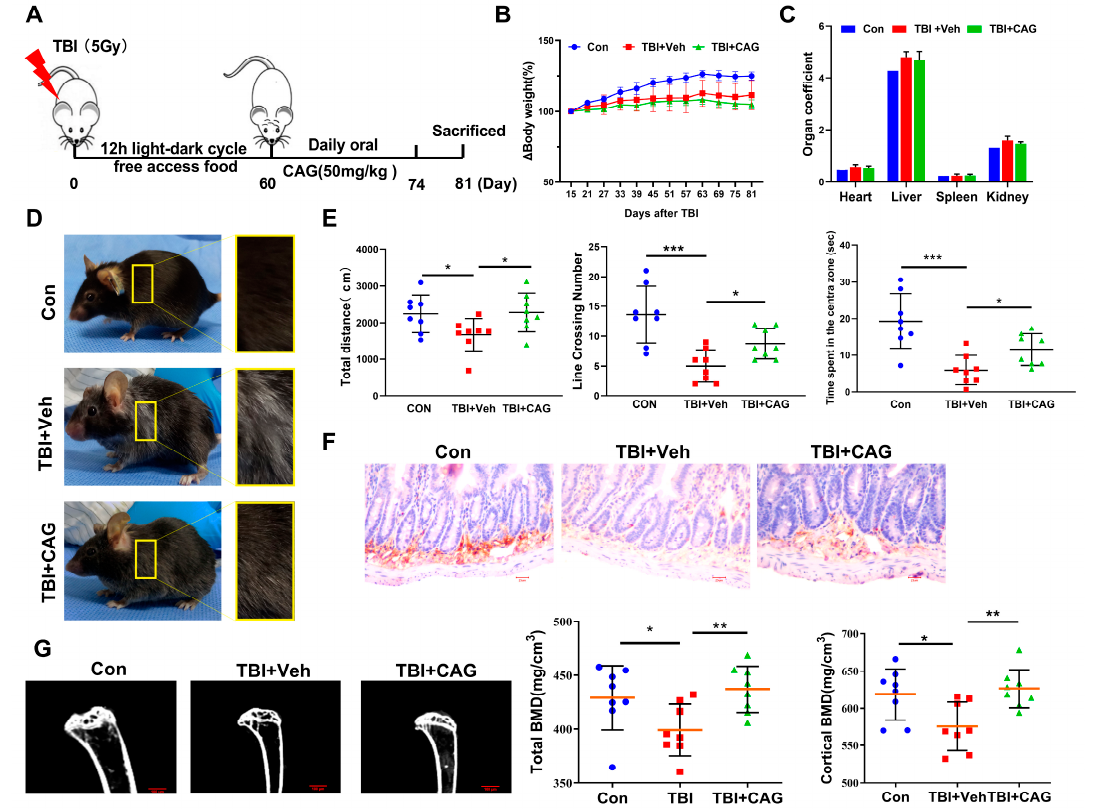
Figure 4. CAG delays age-related symptoms and organ aging in TBI-aged mice. ( A ) Schematic representation of the scheduling of TBI exposures. When the irradiated mice developed an age-related phenotype (about 2 months after TBI), the mice were treated with 50 mg/kg CAG or vehicle only for 2 weeks by oral gavage ( n = 8 animals/group). ( B , C ) The body weight and organ coe ffi cients of mice in di ff erent groups were measured. ( D ) Whole-body snapshot comparison of control mice exposed to TBI followed by vehicle treatment, and mice exposed to TBI and treated with CAG. ( E ) The open- fi eld test including total distance traveled (cm), line crossing number, and center time (s) were recorded for each 5 min block of testing. ( F ) Representative images of GLR5-positive cells in the small intestinal crypts with immunohistochemistry staining. Microscopic (magni fi cation of 400×) images were taken. ( G ) Representative 3D trabecular bone images of femur and quanti fi cation of bone mineral density (BMD) in di ff erent mouse groups using micro-CT after sacri fi ce. * p < 0.05, ** p < 0.01, and *** p < 0.001.